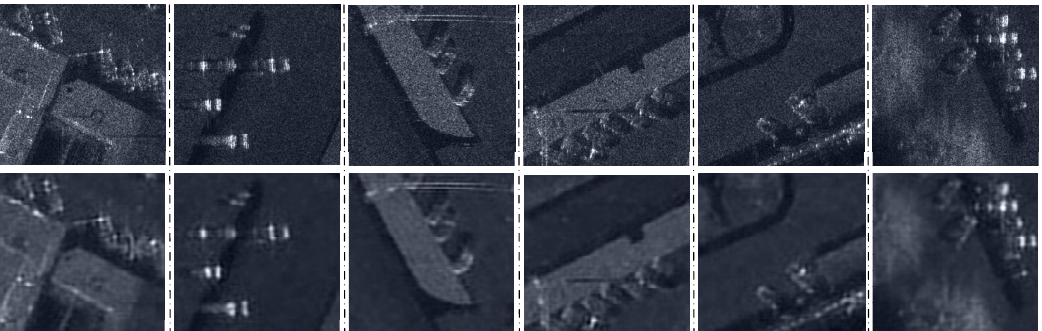
only 30% of the data contain labels and the rest are unlabeled. For the unlabeled miniSAR